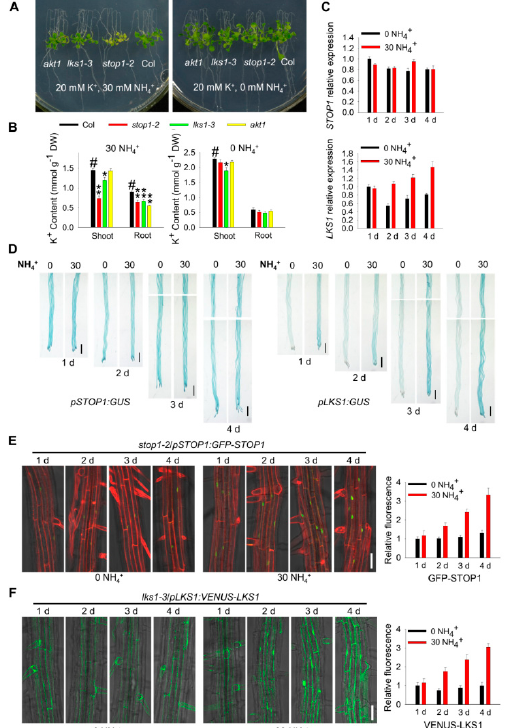
Figure 9. STOP1 and LKS1 are involved in the high-NH 4+ response. ( A ) Phenotype test of akt1 , stop1 , and lks1 mutants on high-NH 4+ (30 mM) and low-NH 4+ (0 mM) medium. Seeds were germinated on low-NH 4+ (0 mM) medium for 5 days, and then the seedlings were transferred to high o-r low-NH 4+ medium for 10 days. ( B ) K + content measurement of indicated plants shown in ( A ) after being trans- ferred to high- or low-NH 4+ medium for 7 days. Data are shown as means ± SE ( n = 4). Student’s t - test (* p < 0.05 and ** p < 0.01) was used to analyze statistical significance; # represents the control. ( C ) RT-qPCR analyses of STOP1 and LKS1 expression in high-NH 4+ response. The 5 day old seed- lings were transferred to high- or low-NH 4+ medium for the indicated times. Then, roots were col- lected and used for RT-qPCR assays. Data are shown as means ± SE ( n = 4). ( D ) GUS staining